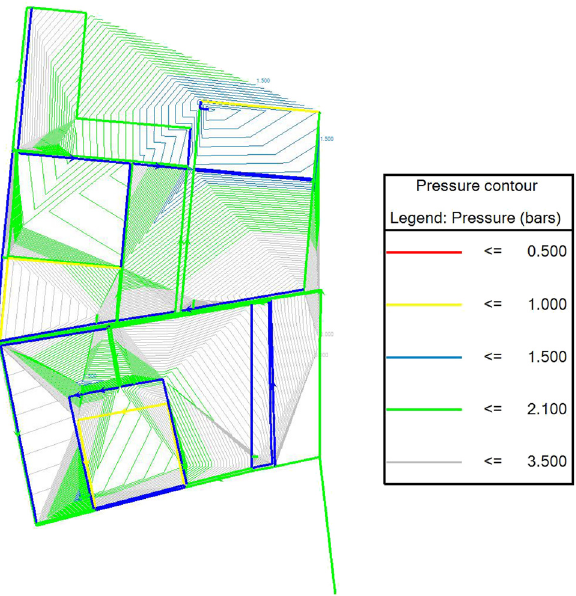
Figure 10: Contour map of pressure heads with improved pump at maximum demand conditions.